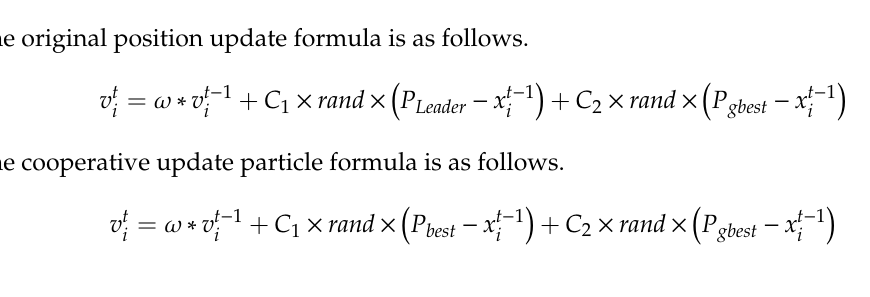
Figure 8. Cooperative update particle swarm